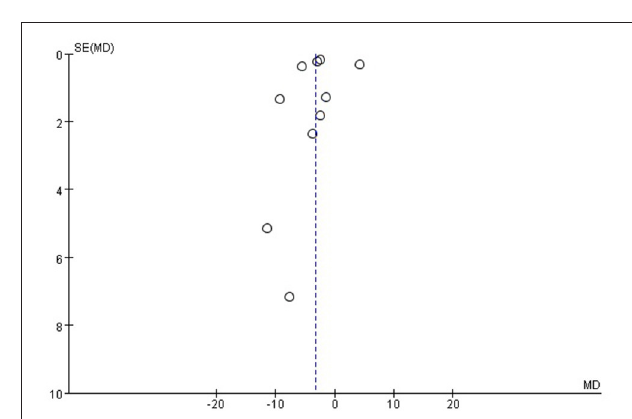
FIGURE 5 | Funnel plot for the systolic blood pressure (SBP). Funnel plot with pseudo 95% confidence limits.